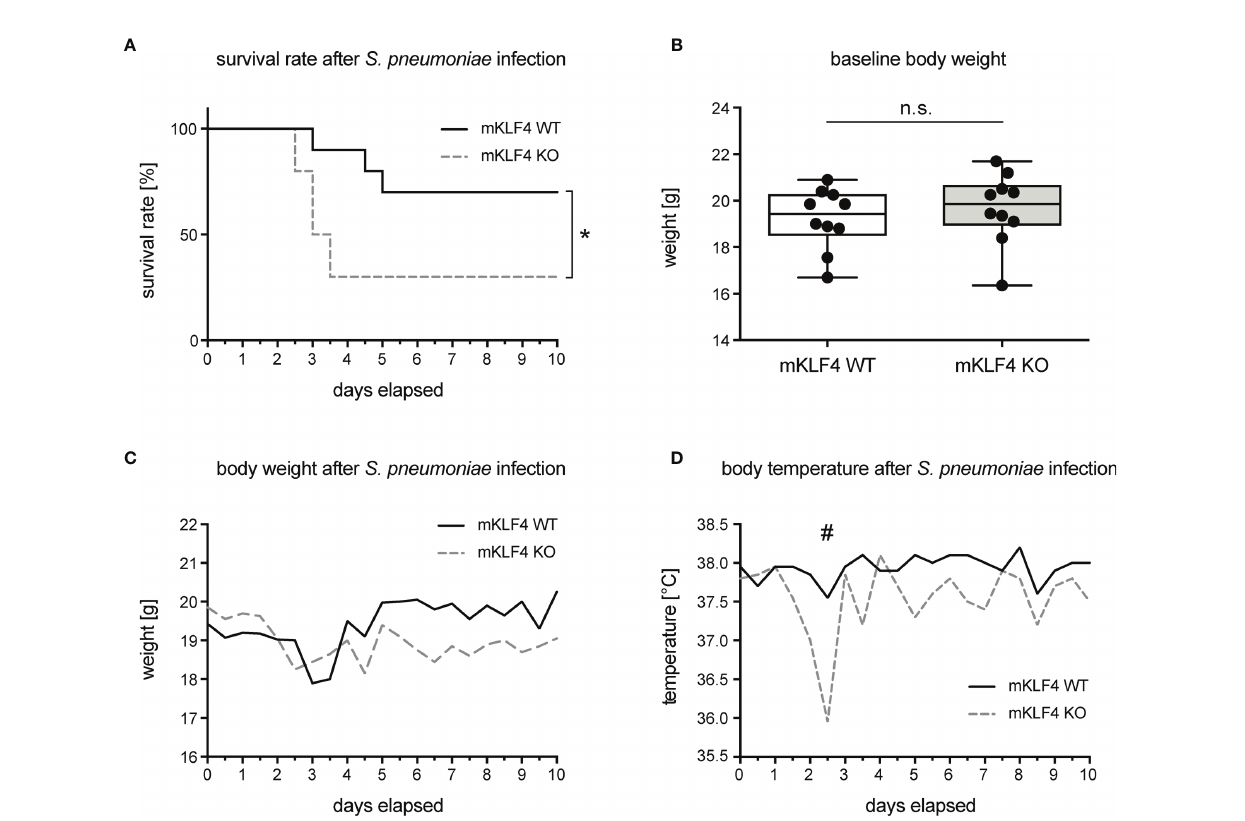
FIGURE 1 | Survival rate, body weight and body temperature of myeloid KLF4 knockout and KLF4 wildtype mice after transnasal infection with S. pneumoniae . Myeloid KLF4 knockout (mKLF4 KO) and KLF4 wildtype (mKLF4 WT) mice were transnasally infected with 5x10 4 CFU NCTC 7978 pneumococci and survival, body weight and body temperature were monitored every 12 hours for 10 days post infection (A, C, D) . Baseline body weight was determined before infection with S. pneumoniae (B) . Graphs show survival proportions of 2 groups starting with 10 mice, each (A) , boxplots with min to max whiskers on linear scale of 10 mice, each (B) , or median starting with 10 mice, each (C, D) . Statistics: Cox-Mantel logrank test (A) , Mann-Whitney U test (B) , or Multiple t-test (C, D) . *p < 0.05, # p = 0.063, n.s., not signi fi